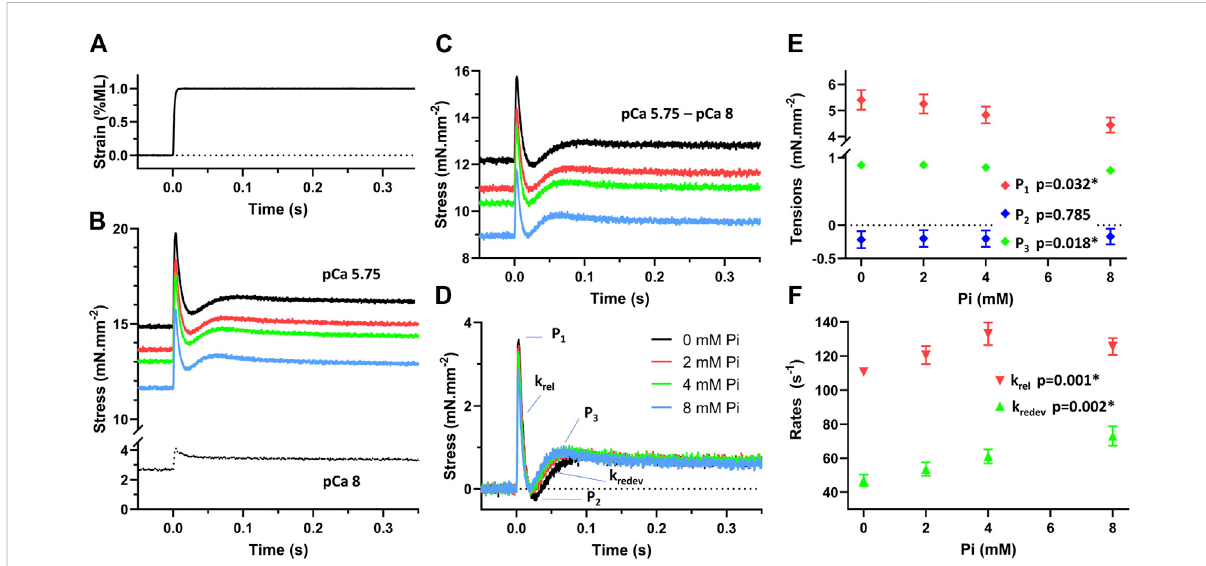
FIGURE 6 Stress response to stretch of demembranated myocardium. (A) Muscle was stretched with a quick stretch of 1% muscle length (ML). (B) The stress response was recorded under relaxed conditions, pCa 8, and at approximately half-activation, pCa 5.75, with 0, 2, 4, and 8 mM Pi. (C) The activated response attributable to the force-producing myo fi laments was determined by subtracting the pCa 8 response from the pCa 5.75 responses. (D) The stretch response of the myo fi laments above the myo fi lament isometric stress was then determined. This response represents the stress change due to the myo fi laments after a quick stretch. (E) Peak tension (P 1 ), lowest tension at nadir (P 2 ), and recovered tension